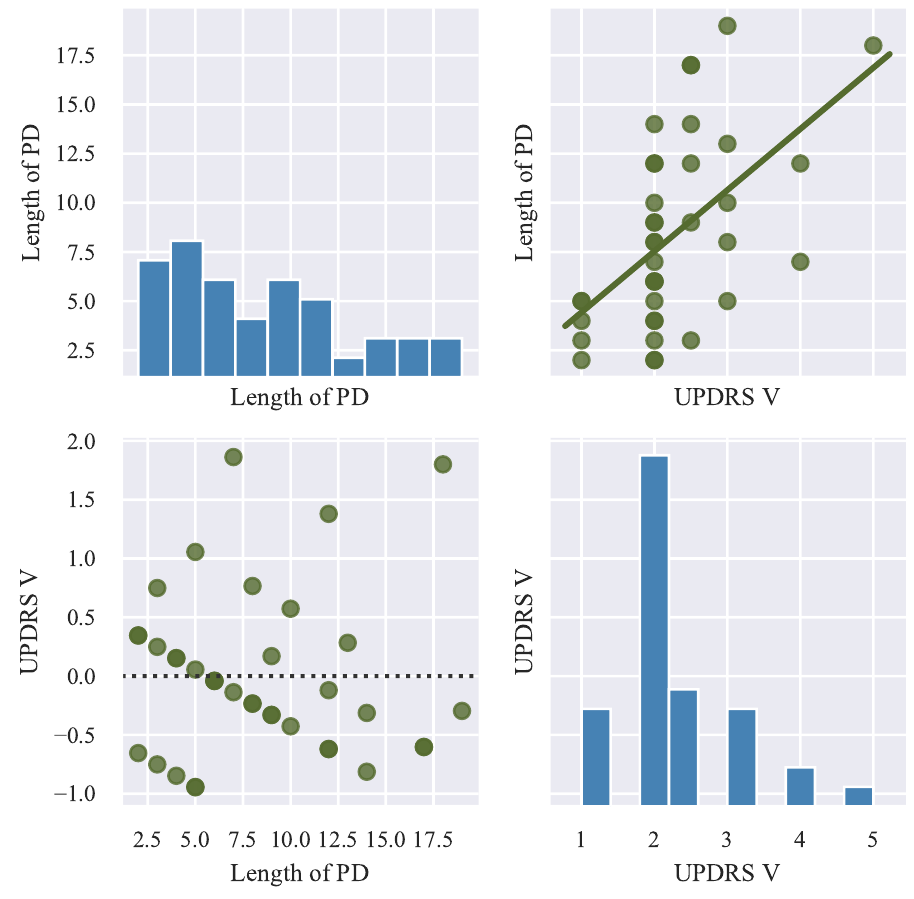
Figure 1. Descriptive graphs of patients’ clinical characteristics: Unified Parkinson’s disease rating scale (UPDRS V) and Parkinson’s disease (PD) duration (in years). Histograms are visualized on the diagonal. A scatterplot with a line fitted using linear regression is visualized in the top-right corner. Residuals of the trained linear model are visualized in the bottom-left